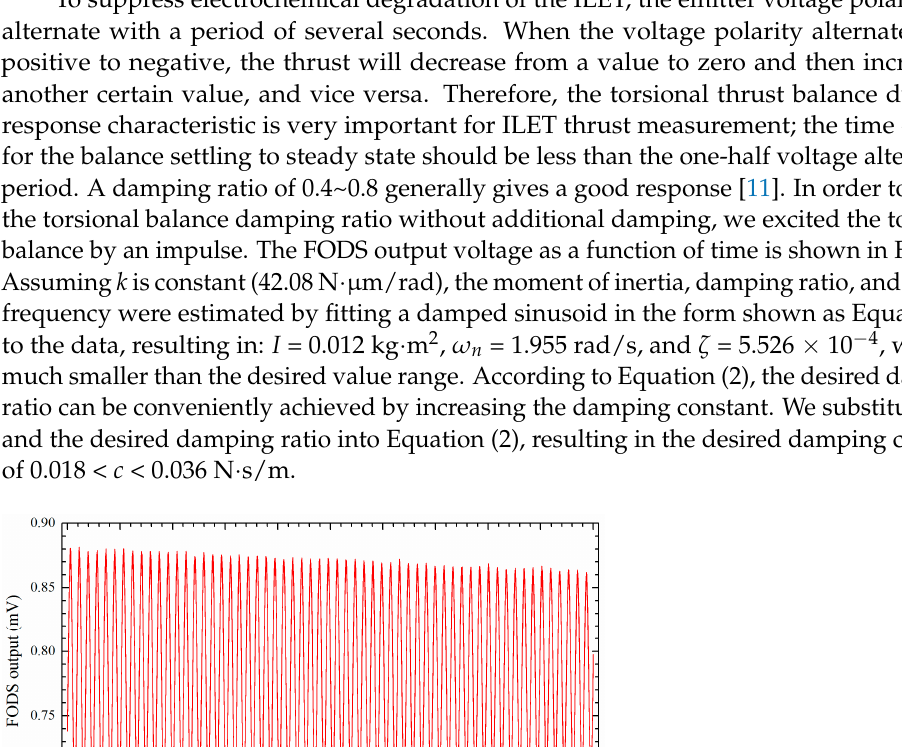
Figure 6. Schematic of the eddy current damper.